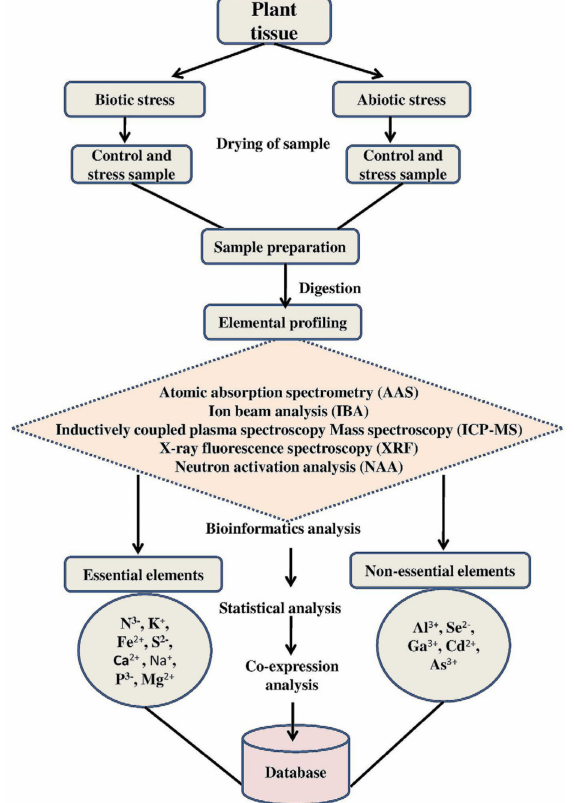
Figure 3. Description of ionomics workflow in plants under control and stress conditions. Sample preparation and elemental profiling using various analytical instruments is emphasized. The role of bioinformatics and other statistical methods to interpret ionomics data that can be stored in a database for future research is also